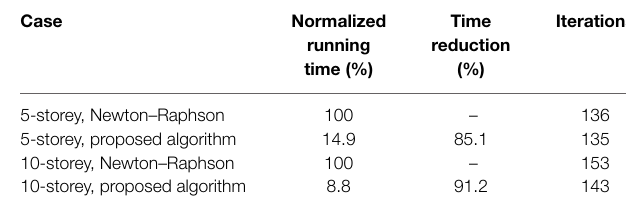
TABLE 2 | Numerical results of the optimization processes the evolution of which is presented in Figure 14 .